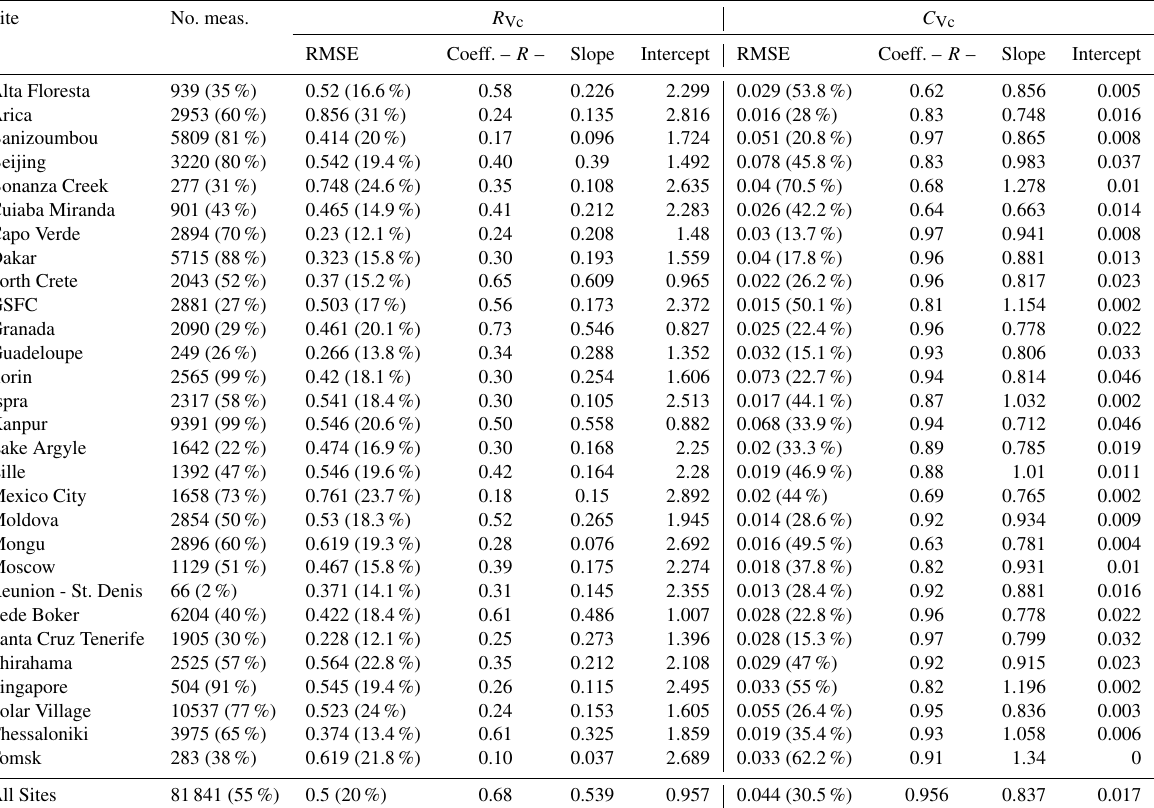
Table 7. Comparison between coarse-mode size parameters obtained from the AERONET standard inversion and GRASP-AOD. The first column presents the site and the second column the number of coincident retrievals accomplishing τ( 440 ) > 0 . 2. The percentage with respect to the total number of coincident retrievals is indicated in parentheses. Columns three to six show the comparison results for coarse-mode volume median radius, while columns 7 to 10 present the results for the coarse volume concentration. In both cases, RMSE (and RMSRE enclosed in parentheses) correlation coefficients, slopes and intercepts from linear regressions are